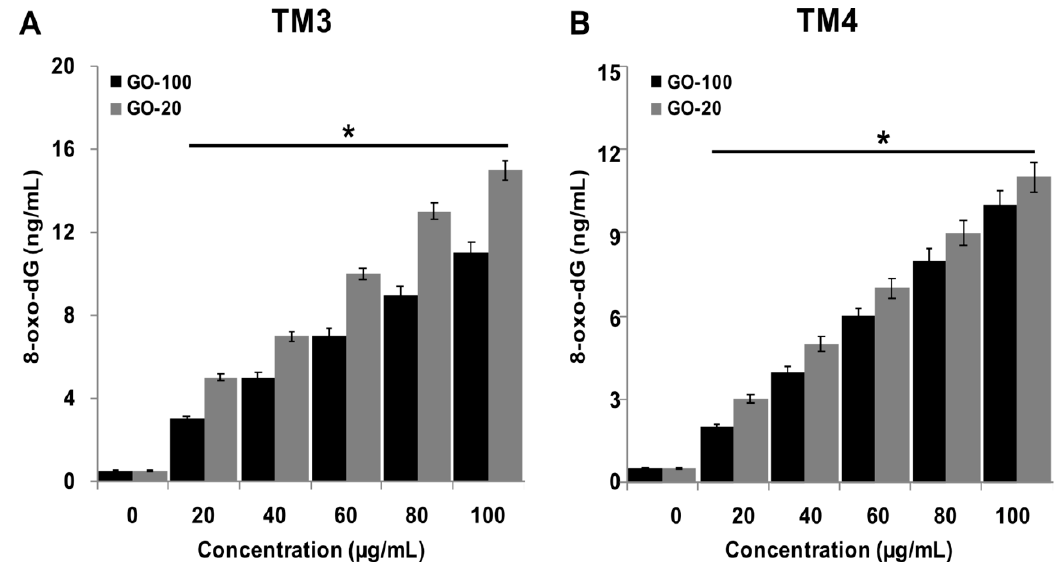
Figure 7. GO-100 and GO-20 graphene sheets induce DNA damage. ( A ) TM3 were treated cells with GO (20–100 μ g/mL) and GO-20 (20–100 μ g/mL) for 24 h and ROS levels were measured using DCFH-DA. ( B ) TM3 cells were treated with GO (20–100 μ g/mL) and GO-20 (20-100 μ g/mL) for 24 h